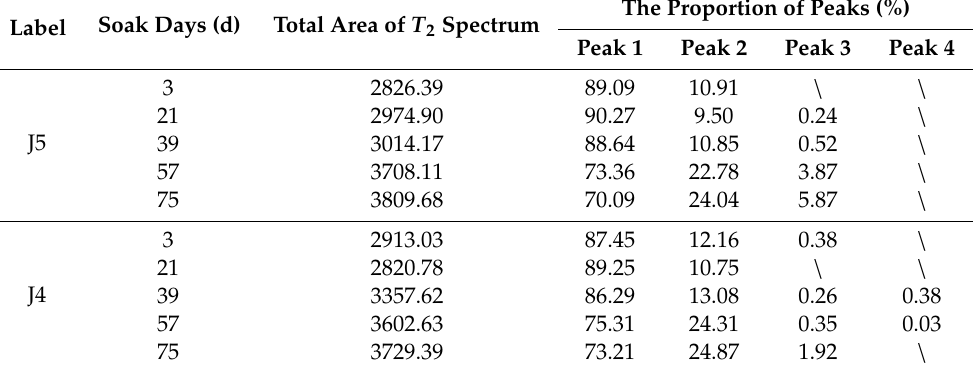
Table 8. T 2 spectrum area and peak proportion of pore